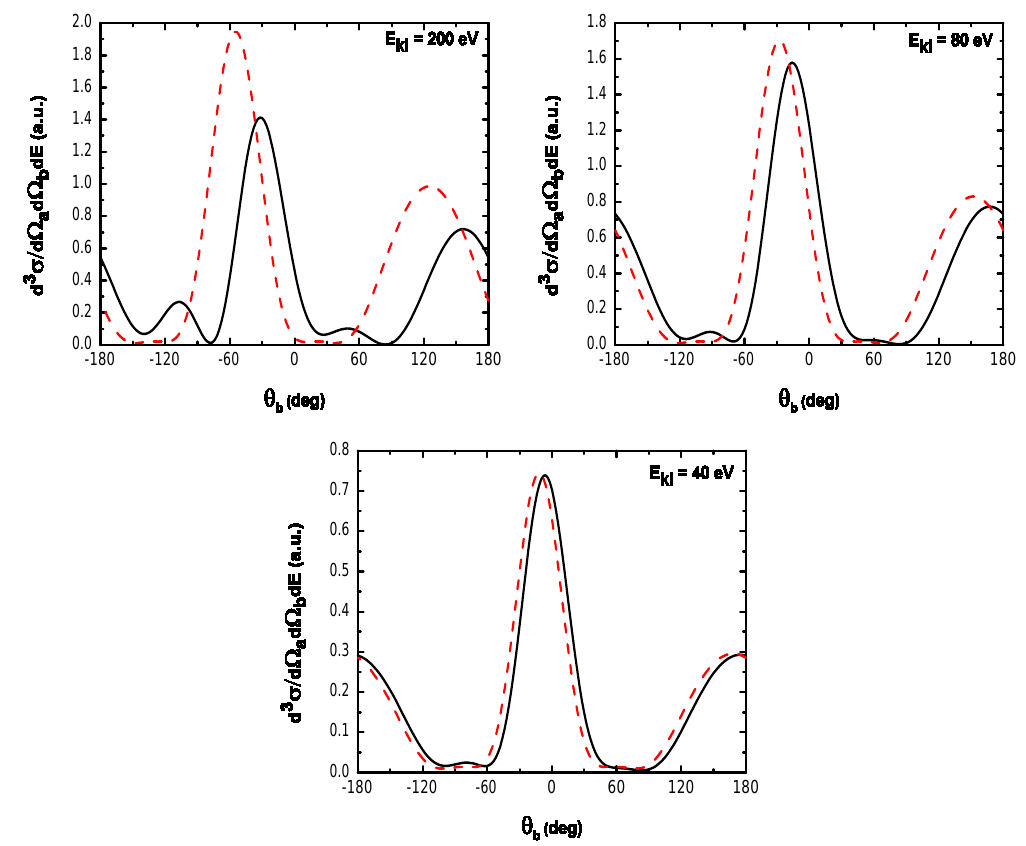
Figure 18. All the parameters are the same as Figure 17, but with the absorption of one photon ( (cid:96) = 1 ) . 5. Laser-Assisted (e, 2e) Collisions in Atomic Hydrogen in the Coplanar Symmetric